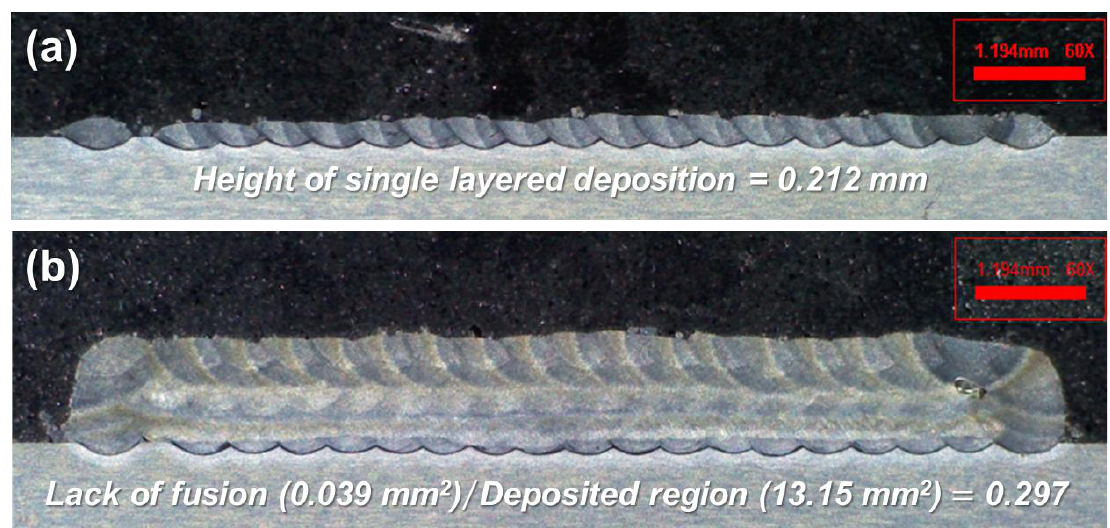
Figure 7. Images of ( a ) single-layered and ( b ) multiple-layered depositions with optimized